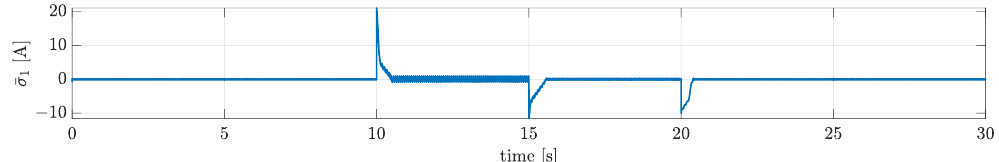
Figure 10. Buck mode. From top to bottom: active duty cycle d 1 ; generator side voltage v C side voltage v C . 2